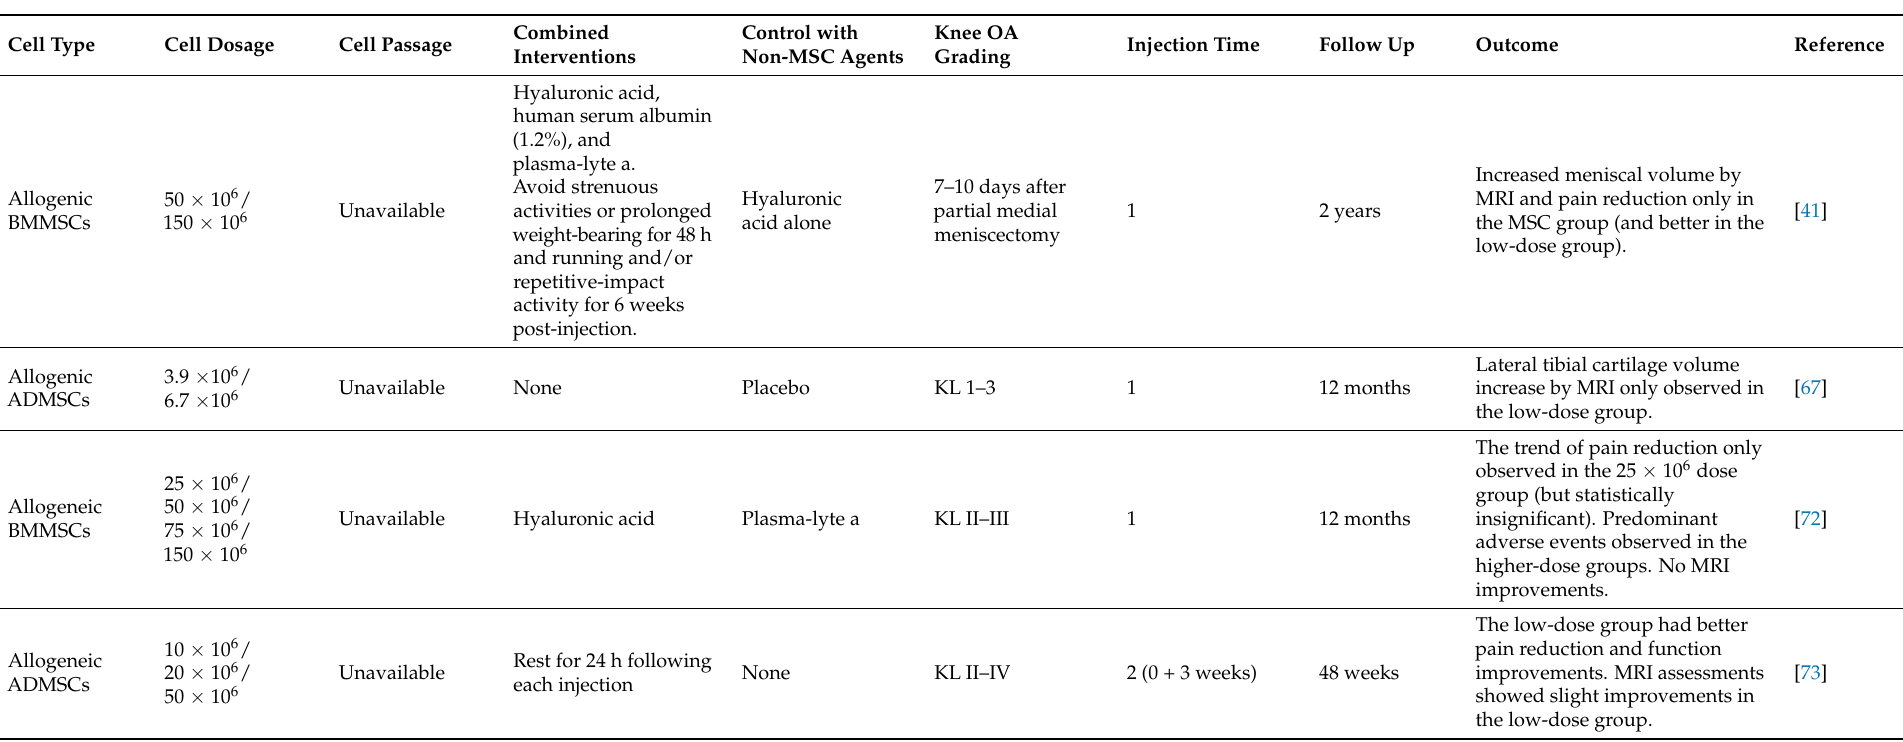
Table 5. Dose-comparison studies using allogeneic